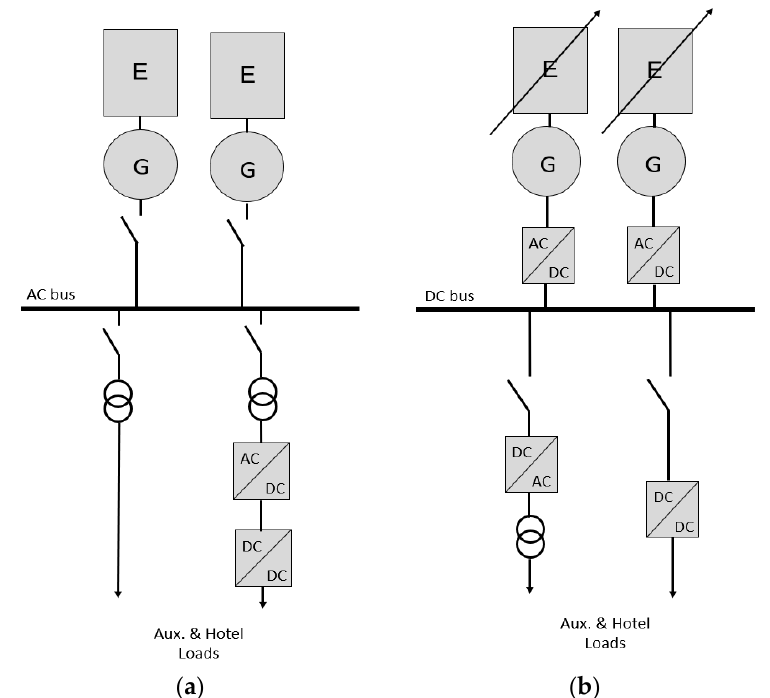
Figure 2. System configuration of AC and DC grid systems in an electric propulsion system; ( a ) AC grid system, ( b ) DC grid system.